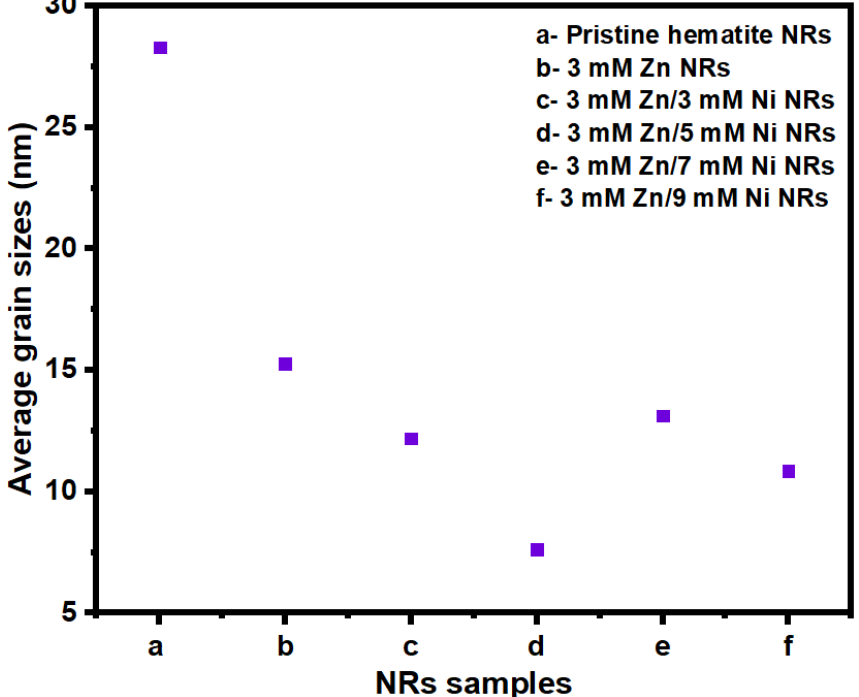
Figure 5. Crystal sizes for pristine hematite NRs, 3 mM Zn, 3 mM Zn/3 mM Ni, 3 mM Zn/5 Mm Ni, 3 mM Zn/7 mM Ni, and 3 mM Zn/9 mM Ni NR samples. 3 mM Zn/7 mM Ni, and 3 mM Zn/9 mM Ni NR